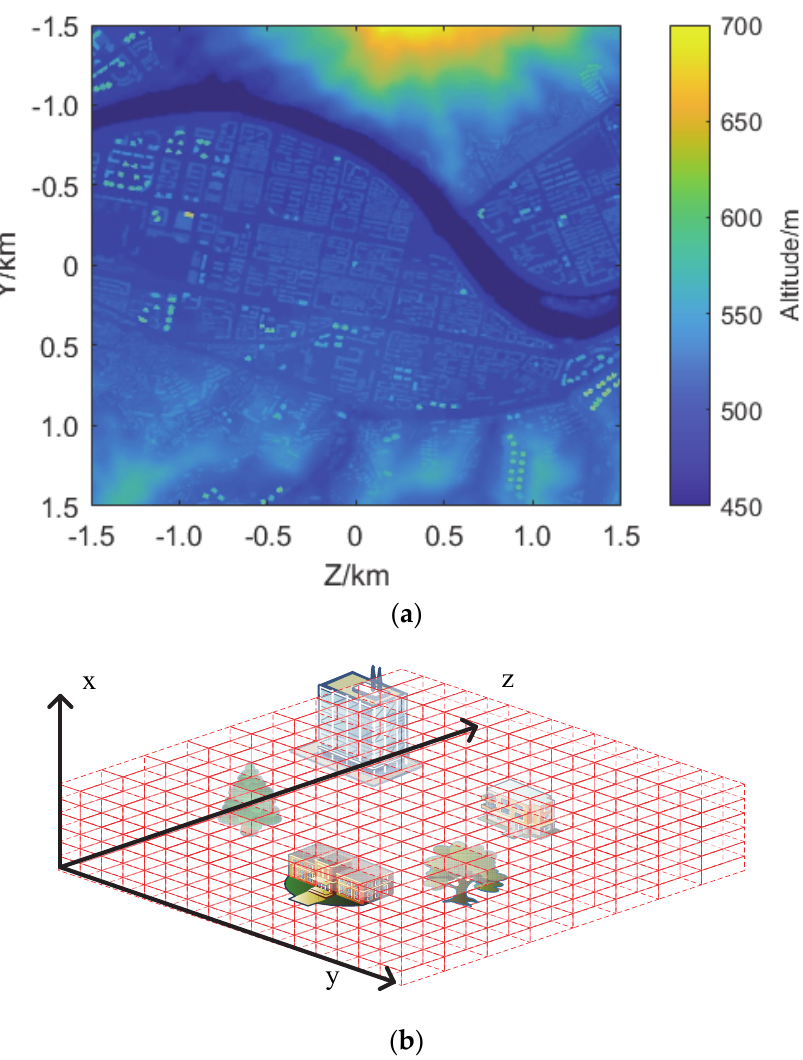
Figure 4. The urban elevation map in ( a ) with altitudes between 450 and 700 m. This map is divided into space cells as shown in ( b ).